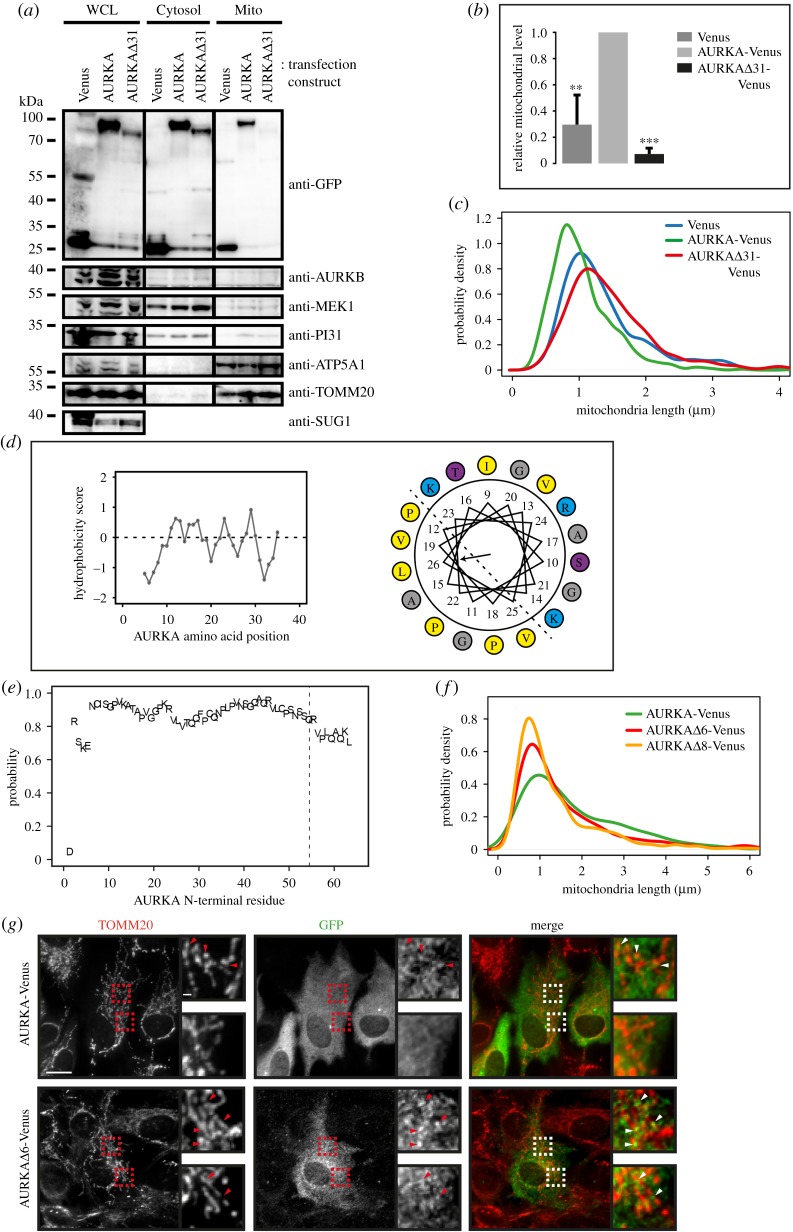
A cryptic mitochondrial targeting sequence resides in the AURKA N-terminus. (a,b) U2OS cells transiently transfected with AURKA-Venus (AURKA), N-terminally truncated AURKA (AURKAΔ31) or Venus alone were fractionated and probed by immunoblot (a) for the presence of Venus (anti-GFP) or with various markers for cytosolic (MEK1, PI31) and mitochondrial (ATP5A1, TOMM20) fractions. SUG1 was used to control for whole-cell lysate (WCL). Venus levels in the mitochondrial fraction (Mito) were quantitated and normalized against the level in WCL (b) in three separate experiments. **p < 0.01; ***p < 0.001 (Student's t-test). (c) N-terminally truncated AURKA (Δ31) does not cause fragmentation of the mitochondrial network. RPE-1 cells transfected with Venus-tagged AURKA, full-length and -Δ31, or Venus control, were treated with MitoTrackerTM and imaged under identical conditions. Mitochondrial tubular lengths are plotted as probability density curves. The two-sample K-S tests of AURKA and AURKAΔ31 populations give p < 0.001 for maximum deviation D = 0.34, from two repeats. (d) Likely amphipathic helix in the AURKA N-terminus revealed by Kyte–Doolittle plot (left-hand panel) and Helical wheel projection (right-hand panel) [30]. Yellow, hydrophobic; blue and purple, hydrophilic; grey, neutral. (e) MitoProt prediction of mitochondrial targeting probability [31] for in silico sequential N-terminal truncations of AURKA. (f,g) RPE-1 cells were transfected with wild-type or N-terminally truncated versions of AURKA-Venus (Δ6, Δ8) and imaged 24 h later after staining with MitoTrackerTM for measurements of mitochondrial tubular length (f). By two-sample K-S tests, WT versus Δ6: p < 0.001, D = 0.13; WT versus Δ8: p < 0.001, D = 0.25. Cells were then fixed and processed for IF with GFP and TOMM20 antibodies (g, see also electronic supplementary material, figure S5). For panel (g): scale bars, 10 µm in main panels, 1 µm in magnification panels.